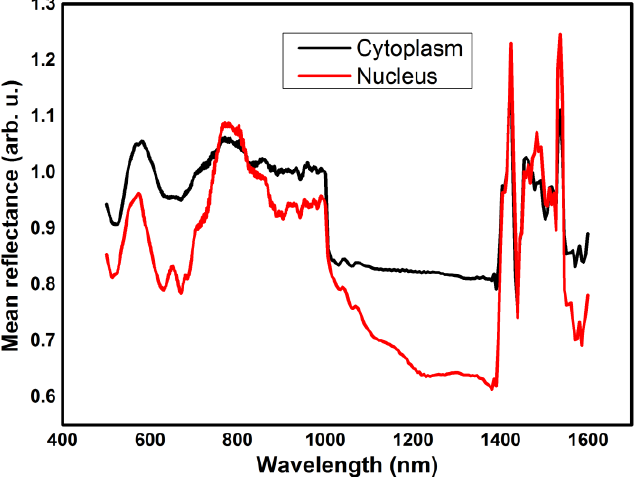
Figure 12. Mean reflectance spectra of cytoplasmic areas (black) and nuclear areas (red) from melanoma cells. Each spectrum is the result of the sum of visible spectrum (500 nm–1,000 nm) data from visible sensor and infrared spectrum (1,000 nm–1,600 nm) data from IR